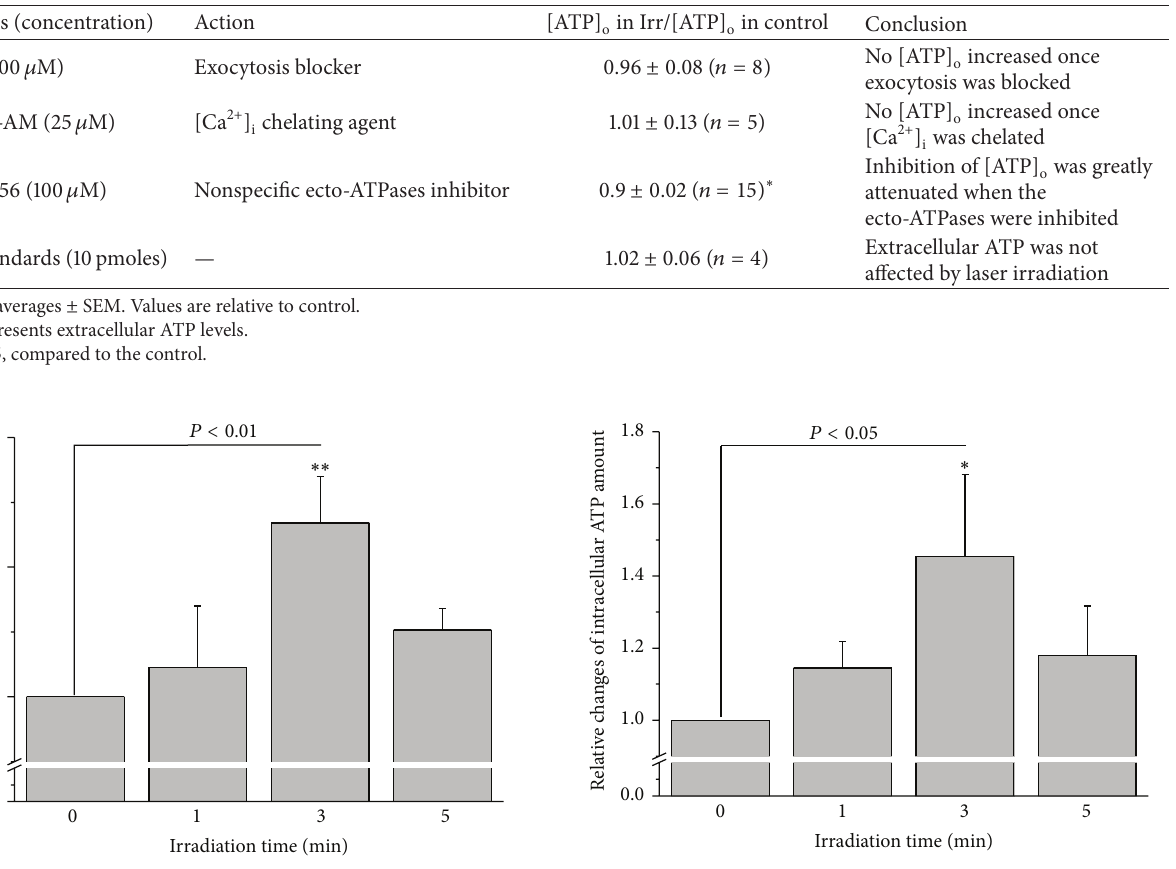
Figure 1: Extracellular ATP content of HMC-1 cells in response to 657 nm and 0.28 W/cm 2 laser irradiation. Relative changes of extracellular ATP level of HMC-1 cells induced by laser irradiation averaged for respective irradiation times of all samples. The data represent averages ± SEM from 𝑁 = 3 - 4 independent experiments. ∗∗ 𝑃 < 0.01 , compared to the preirradiation value.